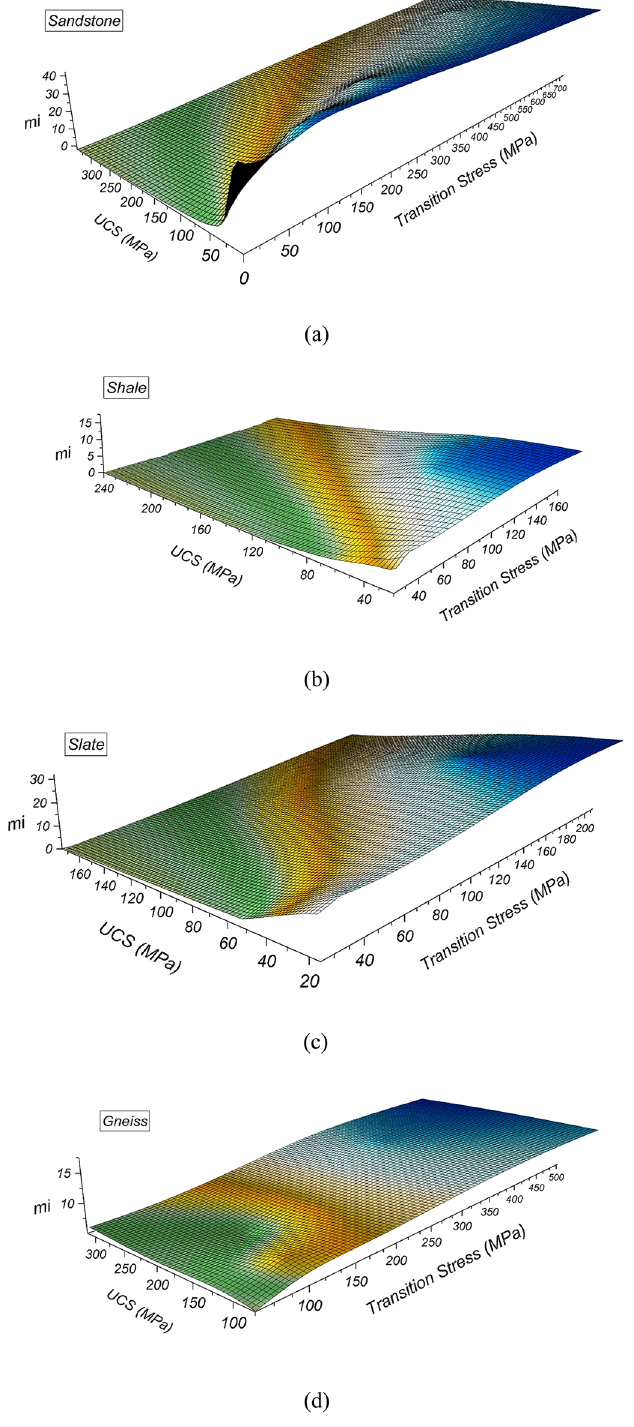
Figure 6. σ TR presented on a color scale as a function of UCS and m i : ( a ) sandstone; ( b ) shale; ( c ) slate; ( d )